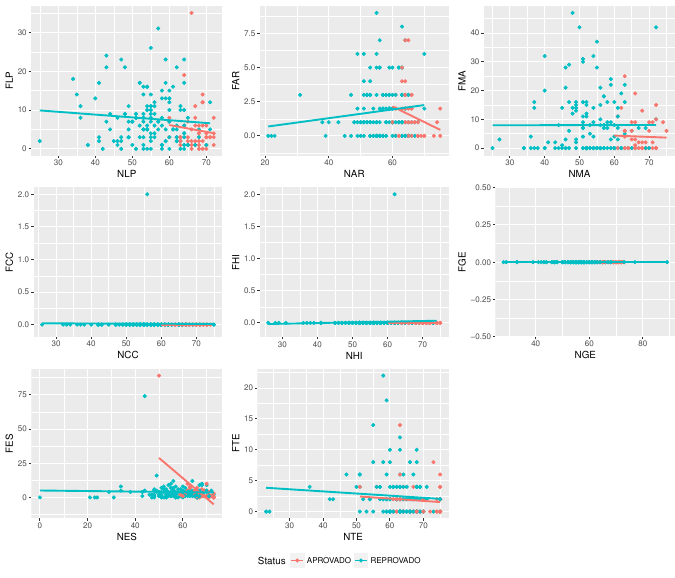
Figure 9. Correlation between discipline’s grade and